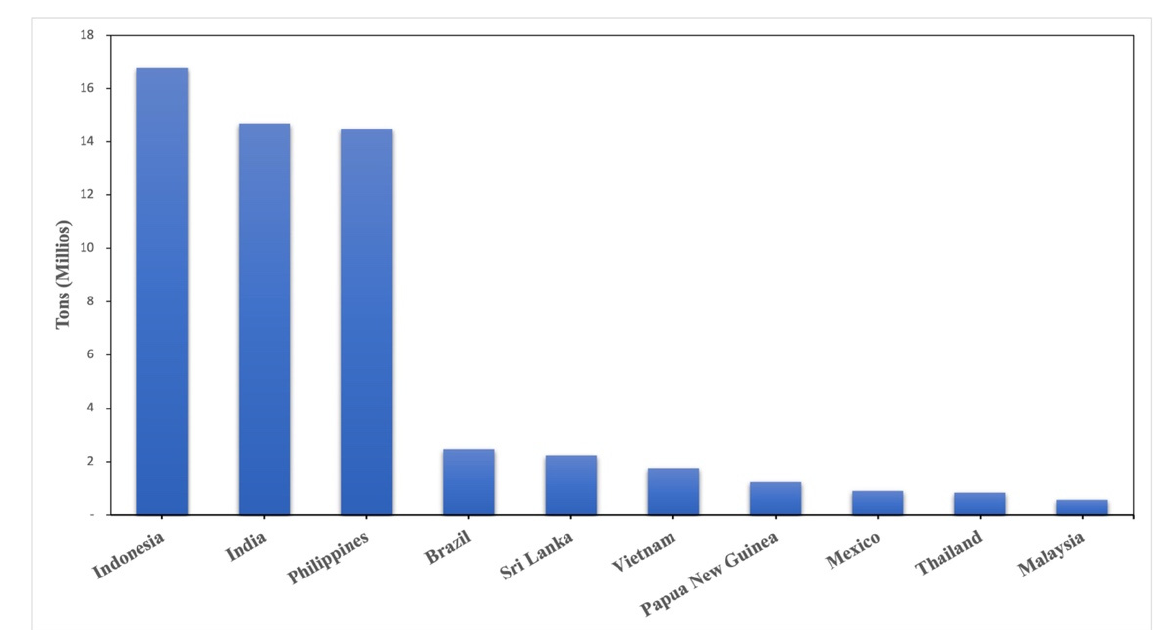
Figure 2. Main coconut producing countries in the world (preparation based on data from FAO,